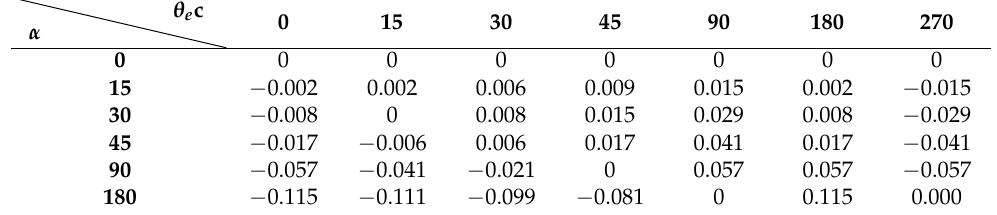
Table 2. Simulation data of the eccentricity error (unit: degree).